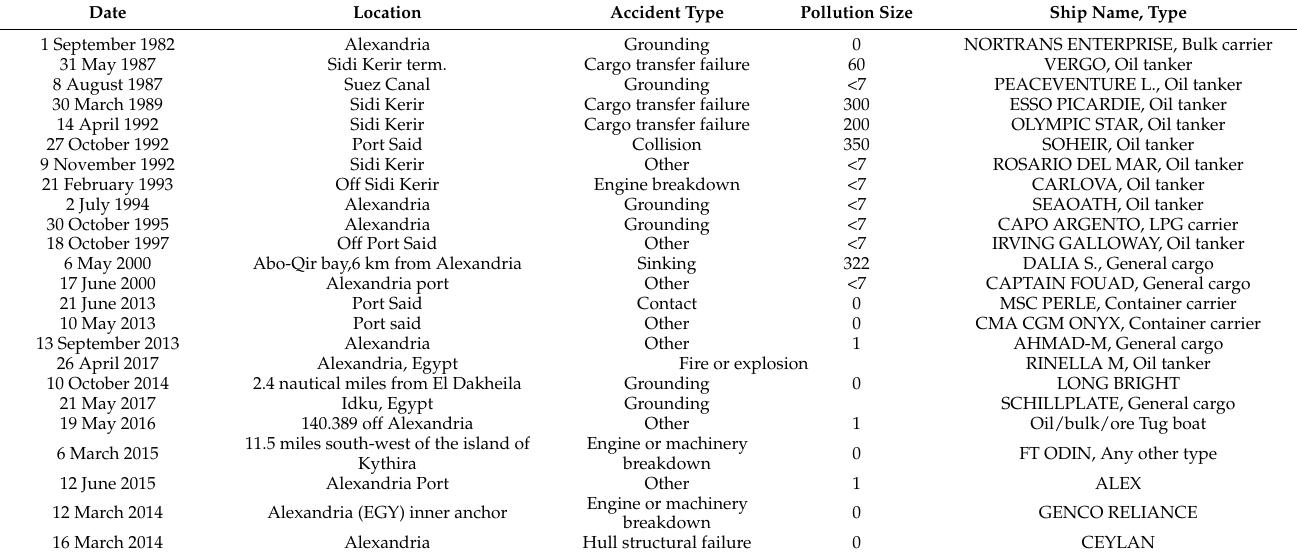
Figure 1. Oil accidents in the eastern Mediterranean Sea during the period of 1990–2013 classified into 3 classes: less than 7 tons, from 7 to 700, and more than 700 tons [8]. Table 1. 24 large oil spills in the Mediterranean waters of Egypt [8].